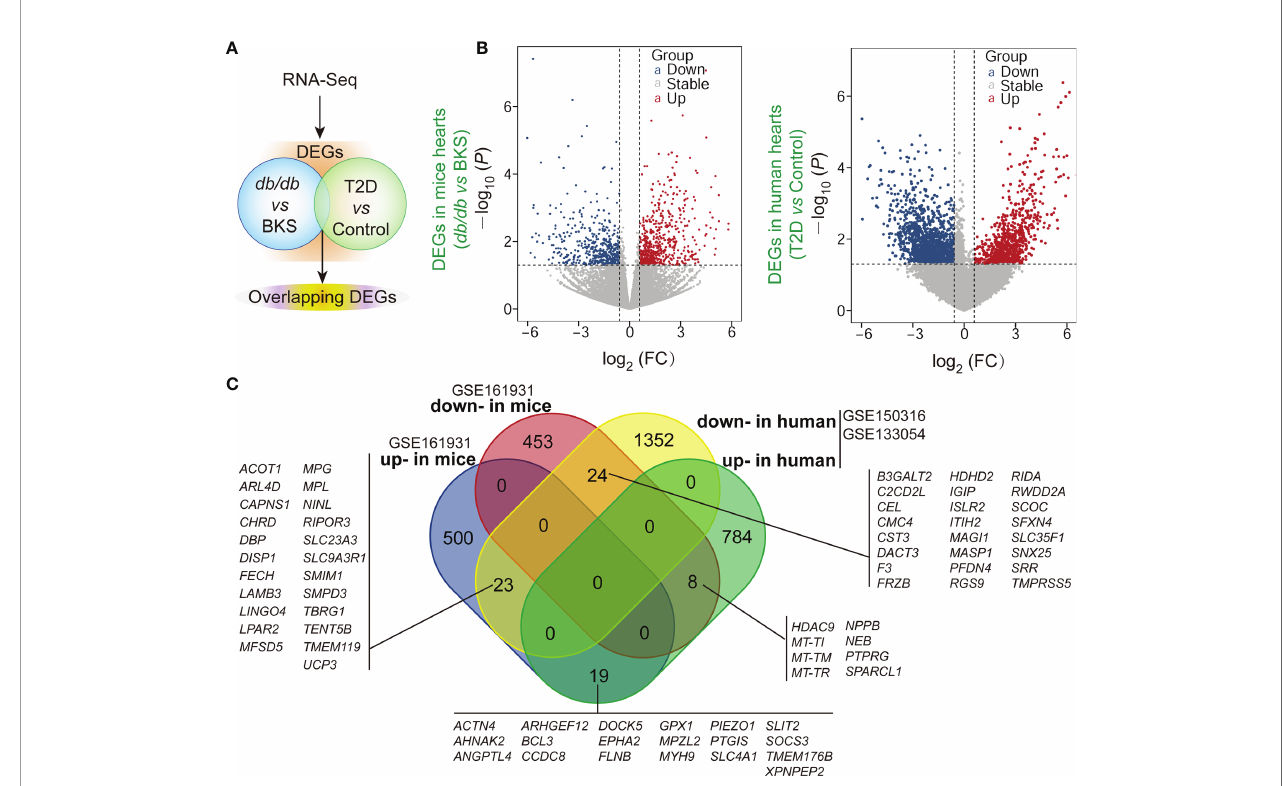
FIGURE 1 | ∣ Identi fi cation of differentially expressed genes (DEGs) and overlapped homologous DEGs in T2D or non-T2D hearts with or without SARS-CoV-2 infection. (A) Scheme of the experimental procedure. The gene expression pro fi les in public datasets from NCBI-GEO were analyzed to identify DEGs in the heart tissues between T2D mice and control, as well as T2D patients who succumbed to SARS-CoV-2 infection and control. (B) Respective volcano plots of sifted out DEGs for datasets in the accordance with public database GSE161931(mice), GSE150316 vs GSE133054 (human) of NCBI-GEO. Blue and red plot represent up- and down-regulated genes, respectively. Gray plot represent the remaining genes with no signi fi cant difference. (C) The Venn diagrams of the overlapping homologous DEGs among the three datasets. Threshold was set to be FC > 1.5 (or <1/1.5) and P <